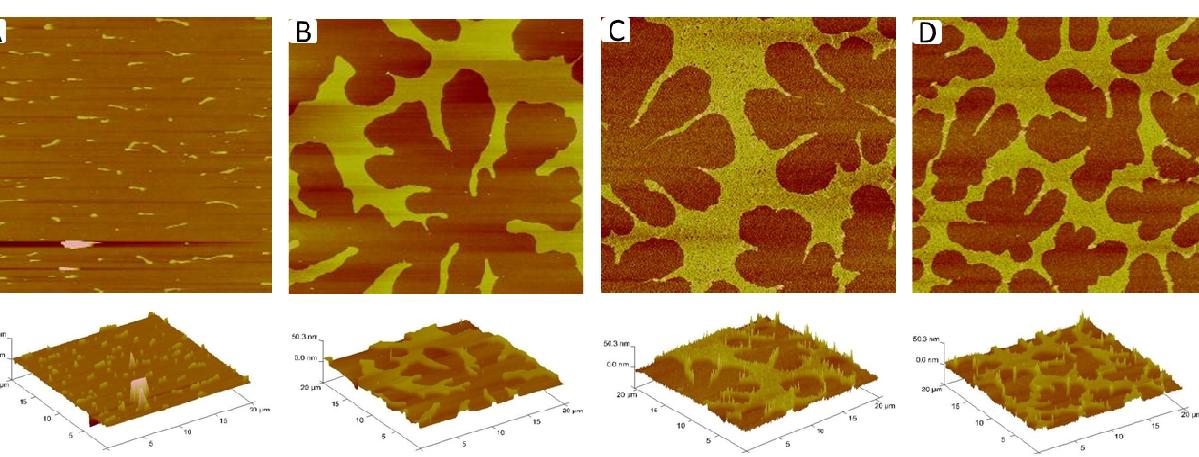
Figure 6. AFM micrographs of different regions of a TYPE 1 physisorbed polymer monolayer exhibiting distinct degrees of membrane buckling: and compartmentalizing buckles of decreasing compartment size ( compartment size indicates increasing lipopolymer molar concentrations. Image size: 20 µm × 20 µm. The buckle amplitude is about